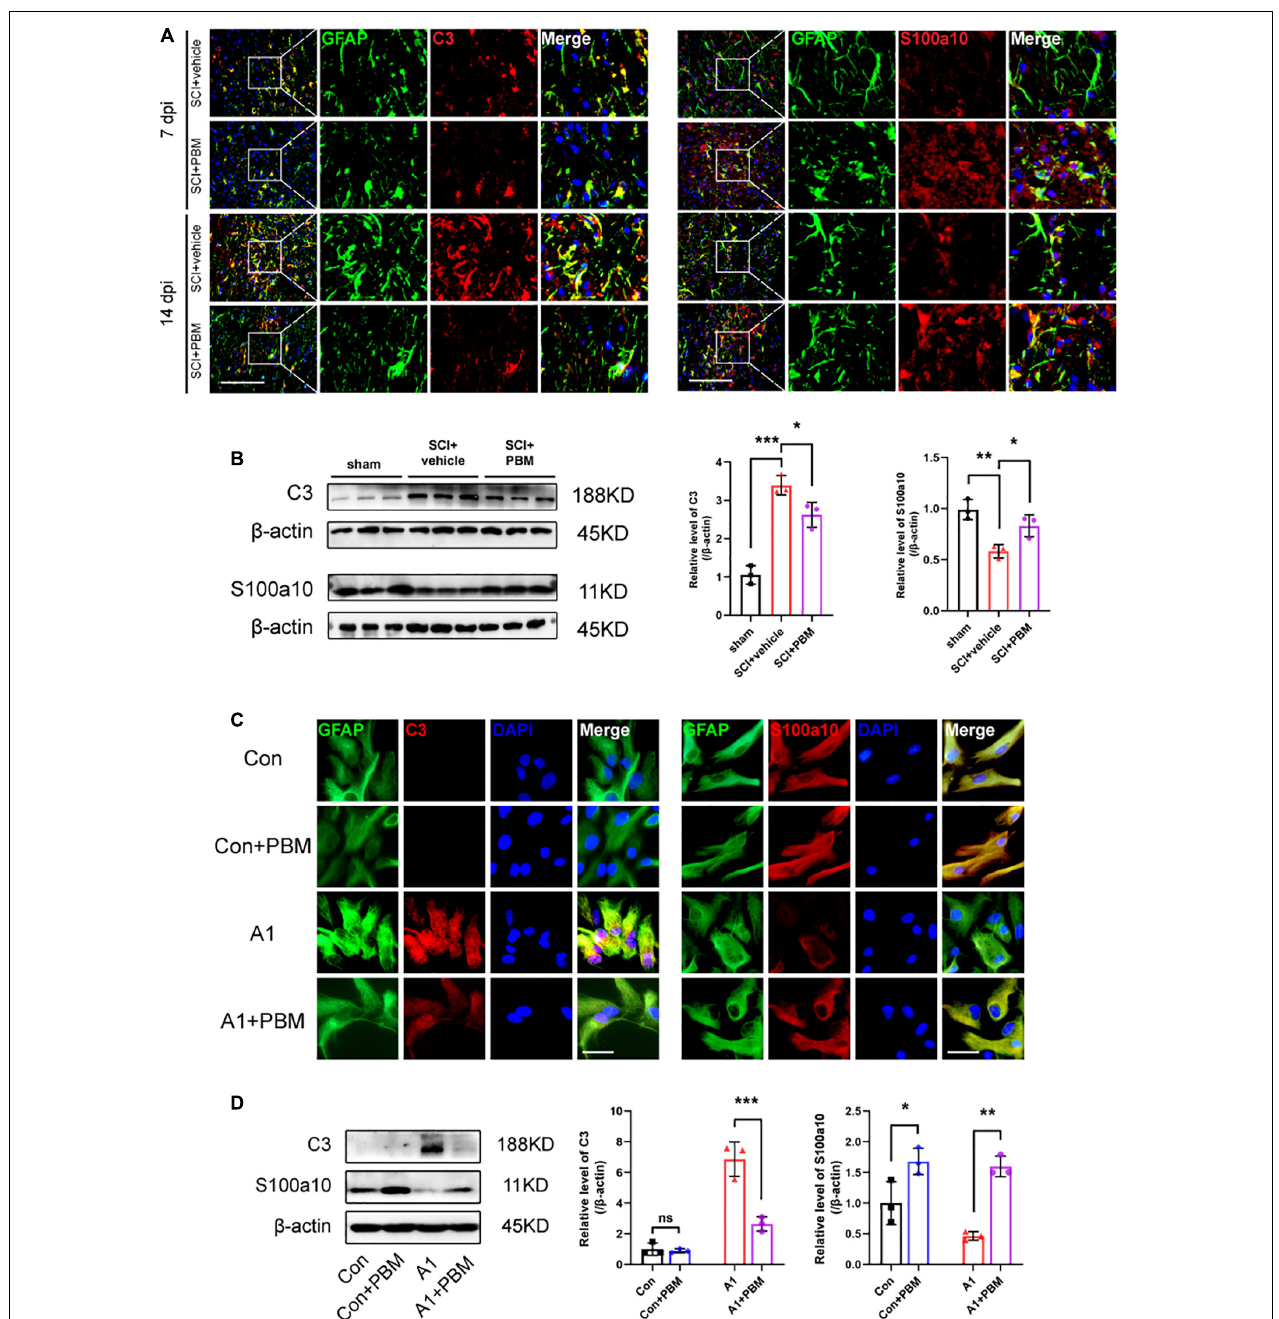
FIGURE 3 | Photobiomodulation modulated the transformation of A1/A2 astrocytes. (A) Representative images of immunofluorescence staining for GFAP (green) and C3 (red) or S100a10 (red) in the lesion area 150 µ m from the epicenter in the SCI + vehicle and SCI + PBM groups at 7 and 14 dpi. Scale bar: 200 µ m. (B) Western blot analysis and quantification of the expression levels of C3 and S100a10 in each group at 7 dpi ( n = 3 individuals per group). (C) Representative immunofluorescence images of GFAP (green) and C3 (red) or S100a10 (red) in astrocytes in the control, control + PBM, A1, and A1 + PBM groups. Con, control; A1, A1 astrocytes. Scale bar: 200 mm. (D) Representative blots and quantification of the expression levels of C3 and S100a10 in each group. The experiments were independently repeated three times. * p < 0.05, ** p < 0.01, *** p < 0.001.